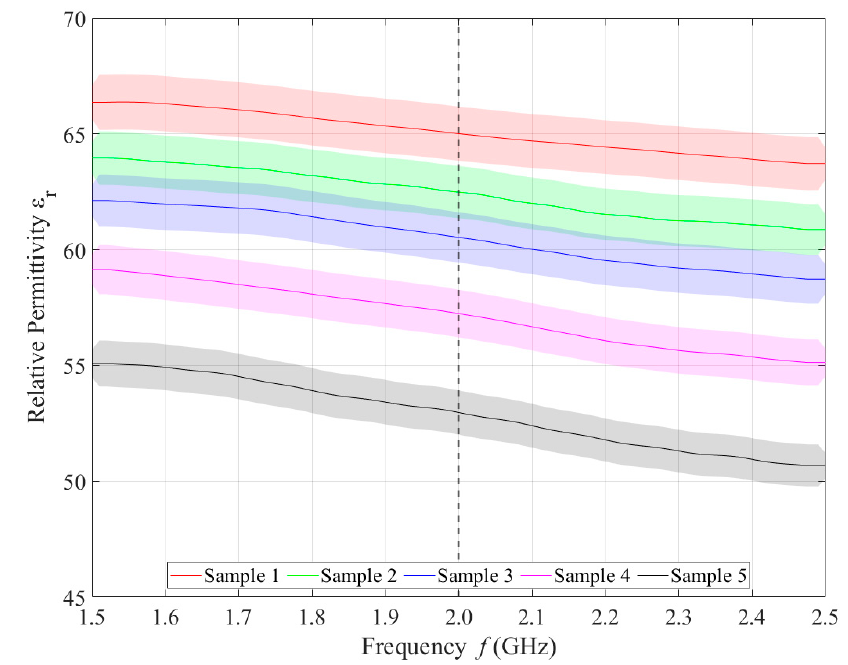
Figure 4. Measured values of relative permittivity.